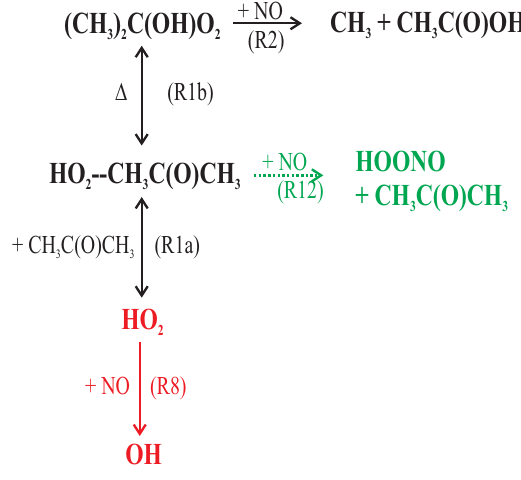
Fig. 1. Depiction of the chemistry described in this manuscript. Re- action with NO (R8, in red) was used to convert HO 2 to OH for detection by LIF in these laboratory experiments (Sect. 2.1). Com- petition from HO 2 + CH 3 C(O)CH 3 leads to reduced OH yields, from which kinetic and thermodynamic parameters for (R1) were derived (see Sect. 3.1). Note: these experiments did not differenti- ate between the reactions of atmospheric interest (R1–R2, in black) and an alternative removal path for HO 2 (R1a followed by R12, in green), important only in the